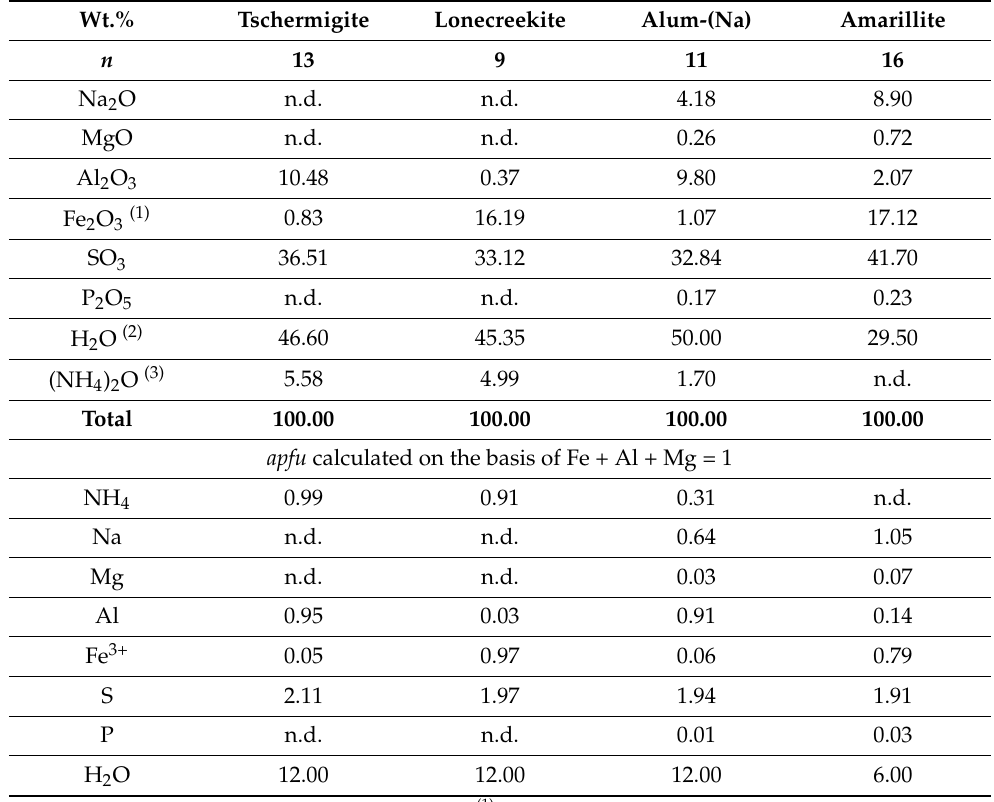
Table 3. Chemical composition of amarillite and alum-group minerals: tschermigite, lonecreekite and alum-(Na) from Dachnoe thermal field normalized to